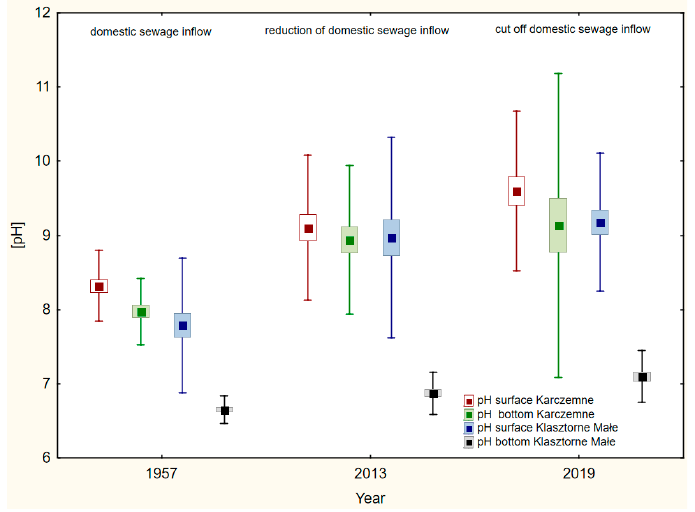
Figure 3. Mean annual values of pH (box ± SEM; whisker plots ± SD) in the water of Karczemne and Klasztorne Ma ł e lakes.